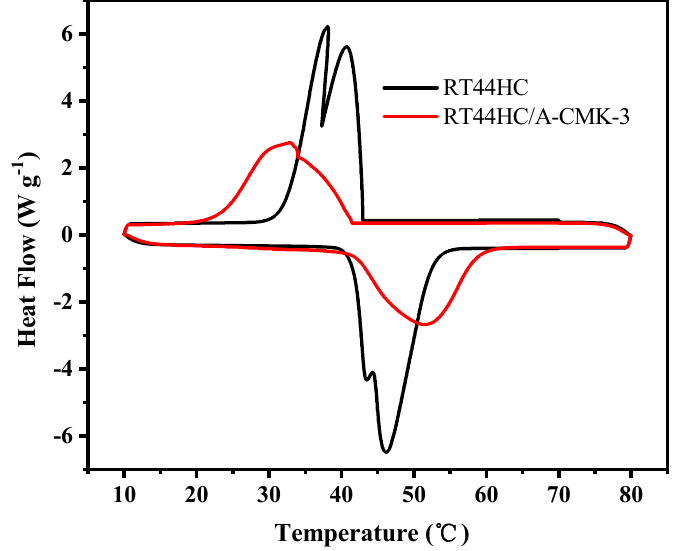
Figure 8. Melting and freezing behavior of A-CMK-3 based PCM.